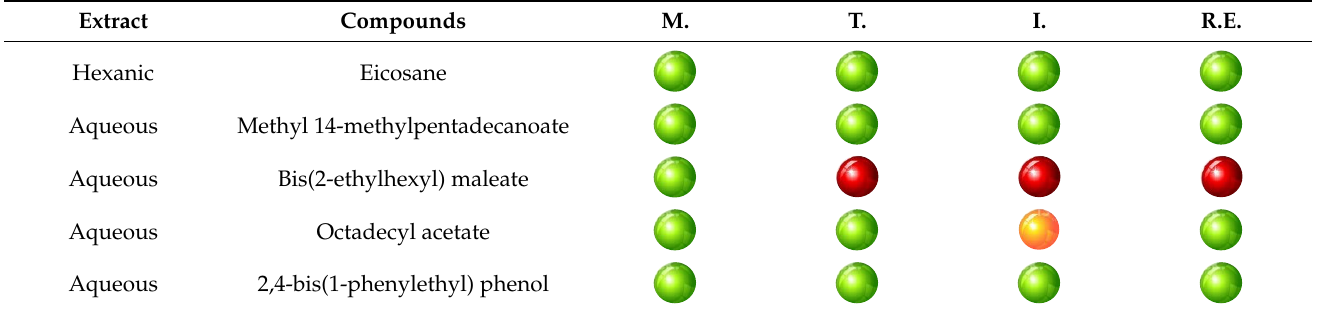
Table 5. Toxicity Risks by OSIRIS Property Explorer. Extract Compounds